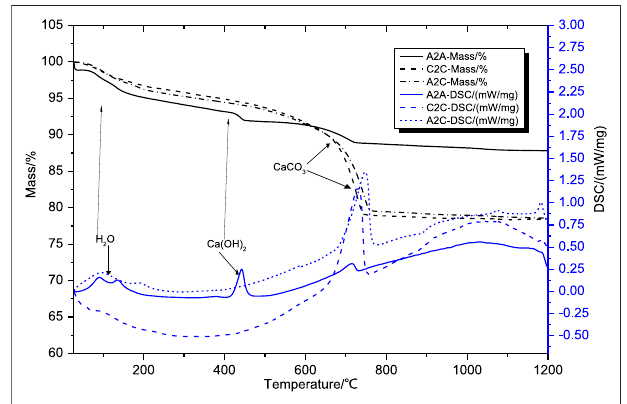
FIGURE 4 | TG-DSC analysis of the uncarbonated area sample from A2A-28d, carbonated area samples from A2C, and C2C in 1d curing age.